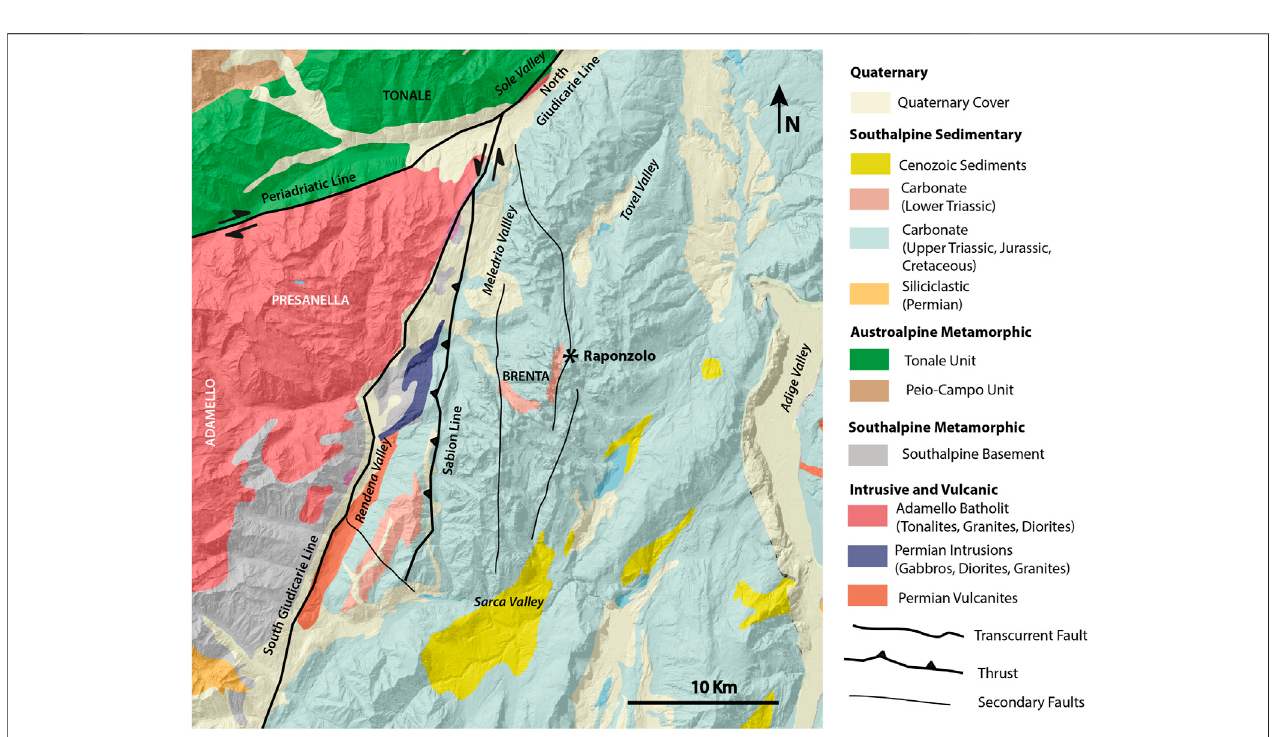
FIGURE 2 | Regional geology of the study area and location of Raponzolo Cave (simpli fi ed from Bigi and Carrozzo, 1992).